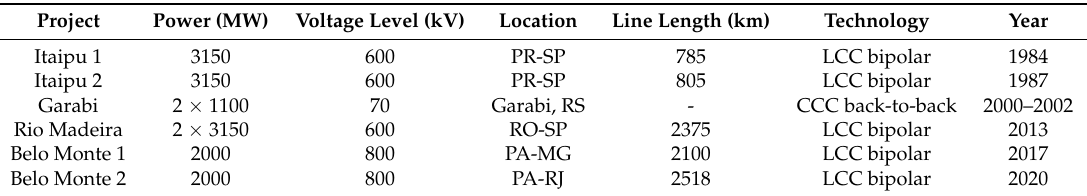
Table 1. HVDC projects in Brazil